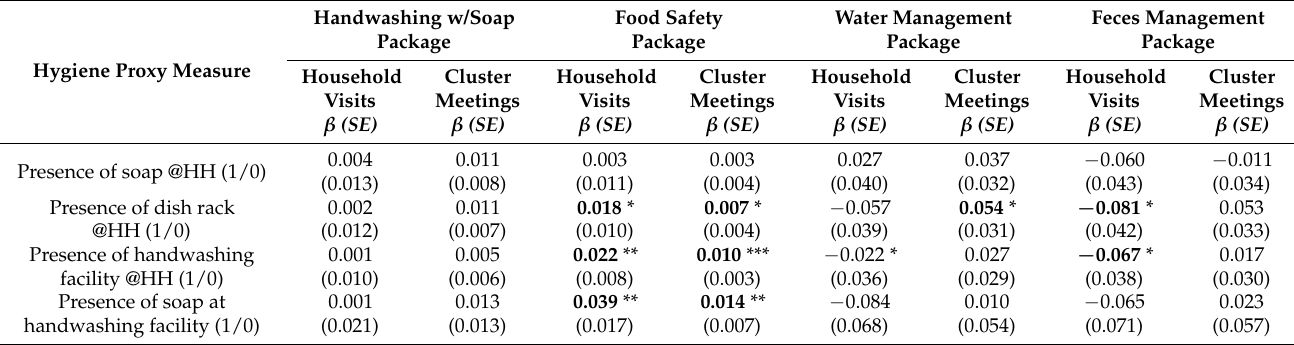
Table 5. Influence of cluster meetings and household visits on the presence of the hygiene proxy measures in the